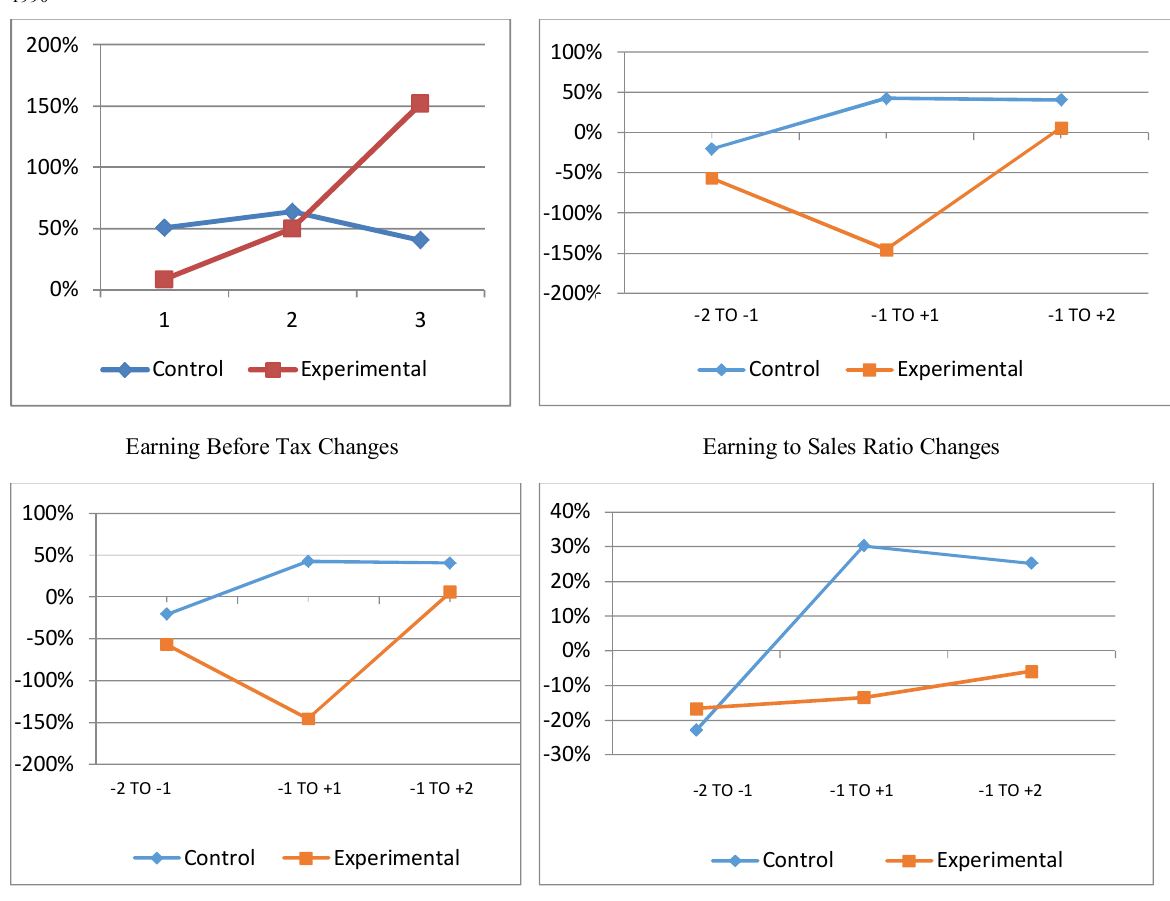
Fig. 1. The summary of some basic statistics The comparison of experiment versus control Mean of Changes Percent Criterion Experimental Group Control Group -2 To -1 -1 To +1 Operational